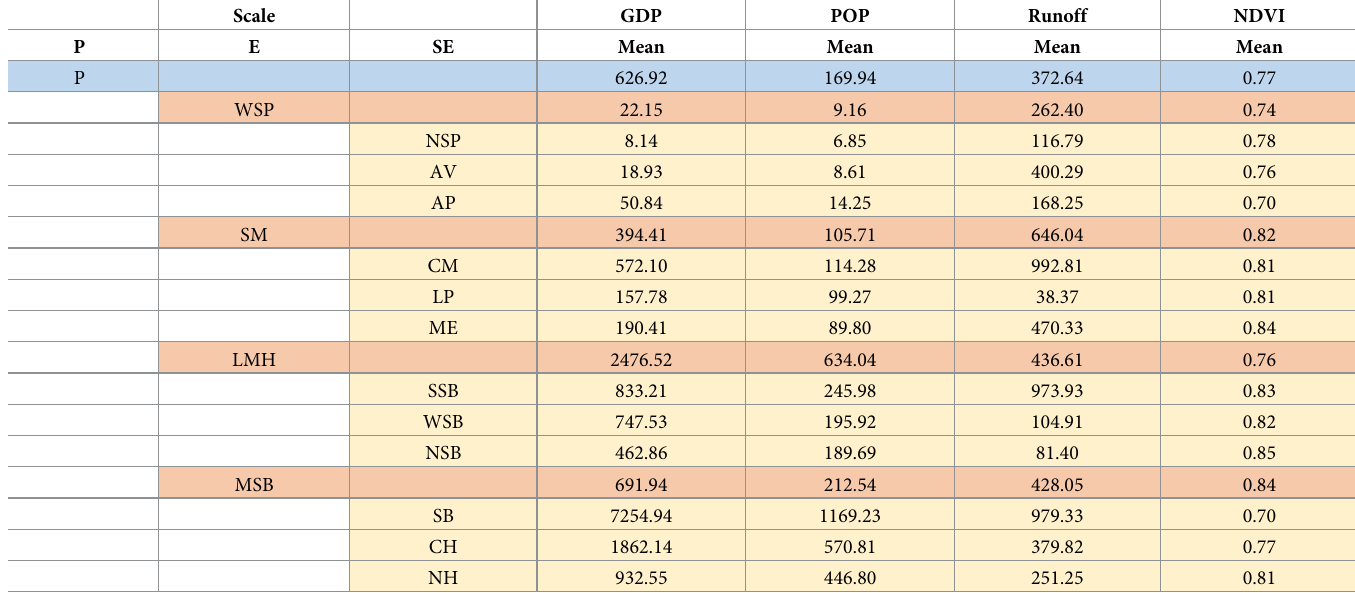
Table 7. Statistical summary of the mean values of the four drivers at the provincial (P) scale, ecoregion (E) scale, and subecoregion (SE) scale. Scale GDP